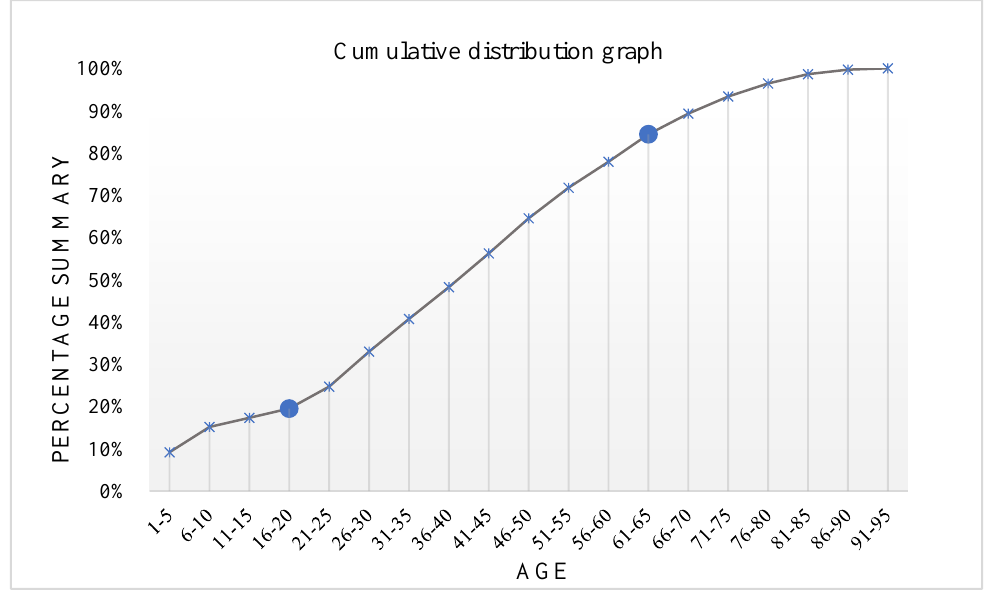
Figure 2. Age cumulative distribution of spontaneous reporting of antibiotics.